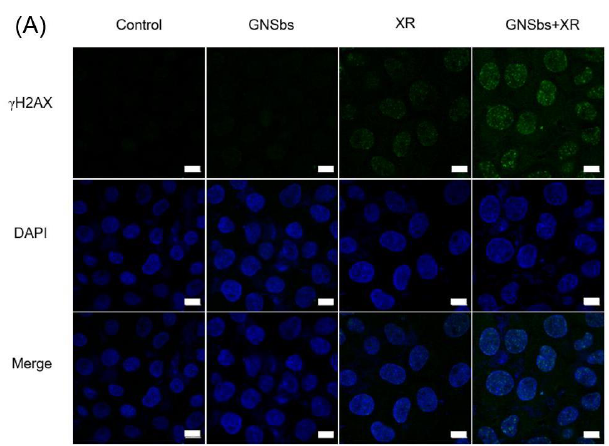
Figure 5. The intracellular ROS levels in CAL27 and L929 cells treated with or without GNSbs (75 µ g mL − 1 ) under radiation (0 and 2 Gy). Cells were exposed to GNSbs at the concentration of 75 µ g mL − 1 for 24 h. Three asterisks (***): p -value < 0.001. 3.6. DNA Damage in CAL-27 and L929 Cells Treated with or without GNSbs under Radiation Double-strand breaks (DSBs) of DNA are the most detrimental lesions correlated with clonogenic cell death upon radiation exposure [21]. In this study, DNA DSBs were analyzed using the γ -H2AX foci assay. The γ -H2AX foci assay can detect the early events that occur upon DSB formation [21] and identify DNA repair inhibition. This information can provide a possible biological mechanism of radiosensitization for GNSbs. The cells (L929 and CAL-27) were cultured with GNSbs for 24 h before radiation treatment. The results (Figure 6) showed that irradiation caused more DNA damage both in L929 and CAL- 27 cells compared to those cells treated without irradiation. In addition, in comparison to irradiation alone, the radiosensitization effect of GNSbs could be noted by the more prominent DNA DSBs in CAL-27 cells. Interestingly, irradiation alone induced more significant DNA damage than GNSbs plus irradiation in L929